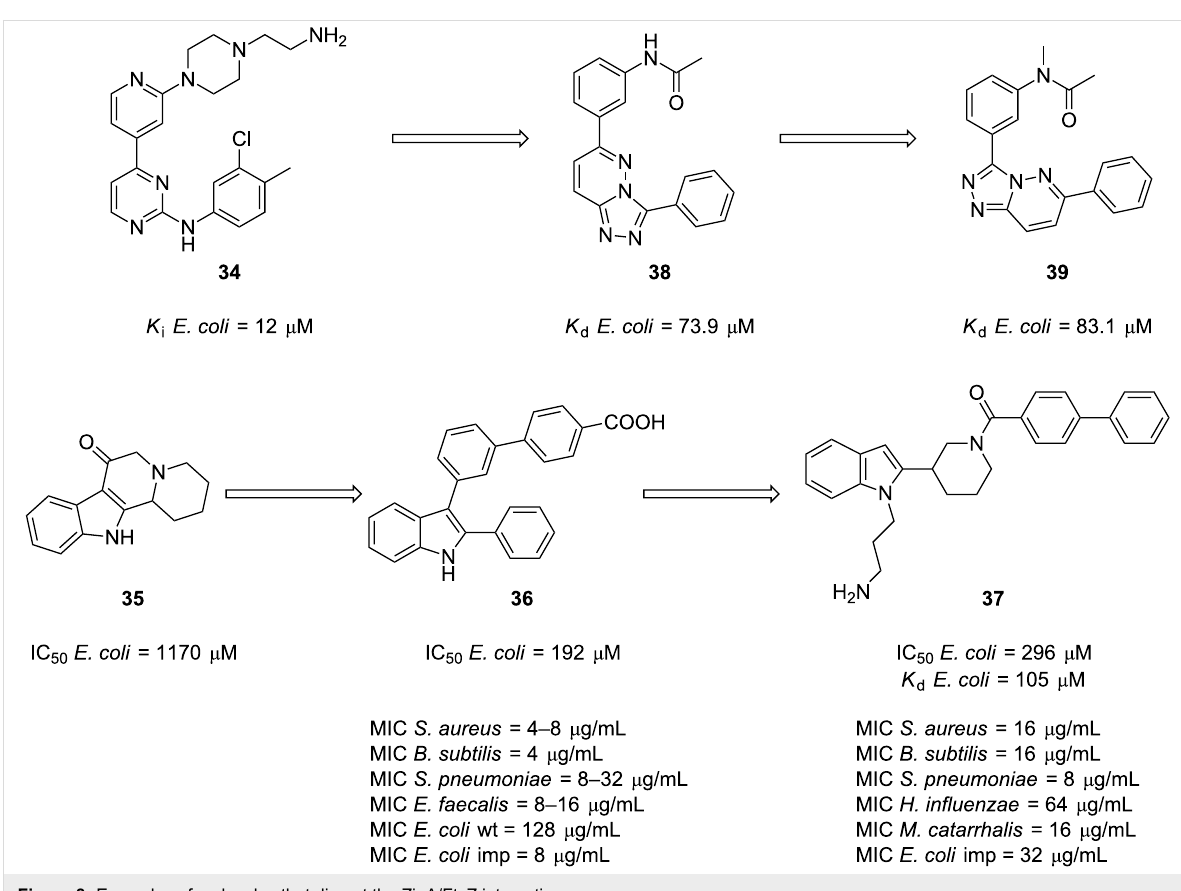
Figure 8: Examples of molecules that disrupt the ZipA/FtsZ